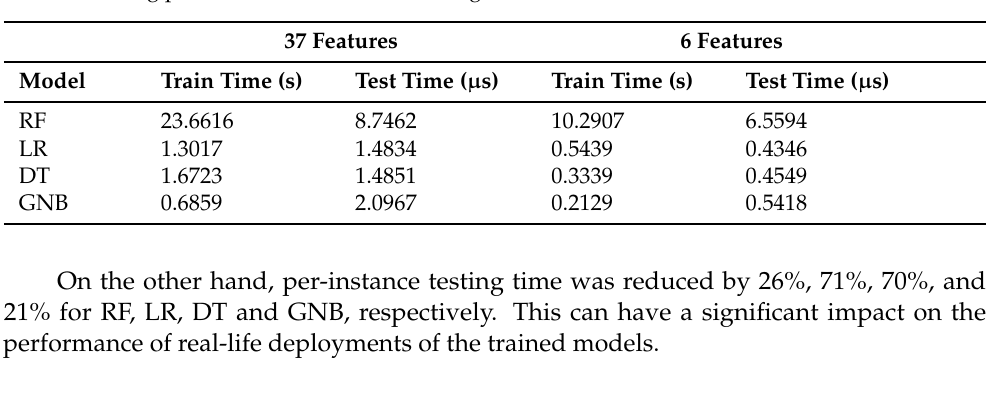
Table 4. Timing parameters of machine-learning